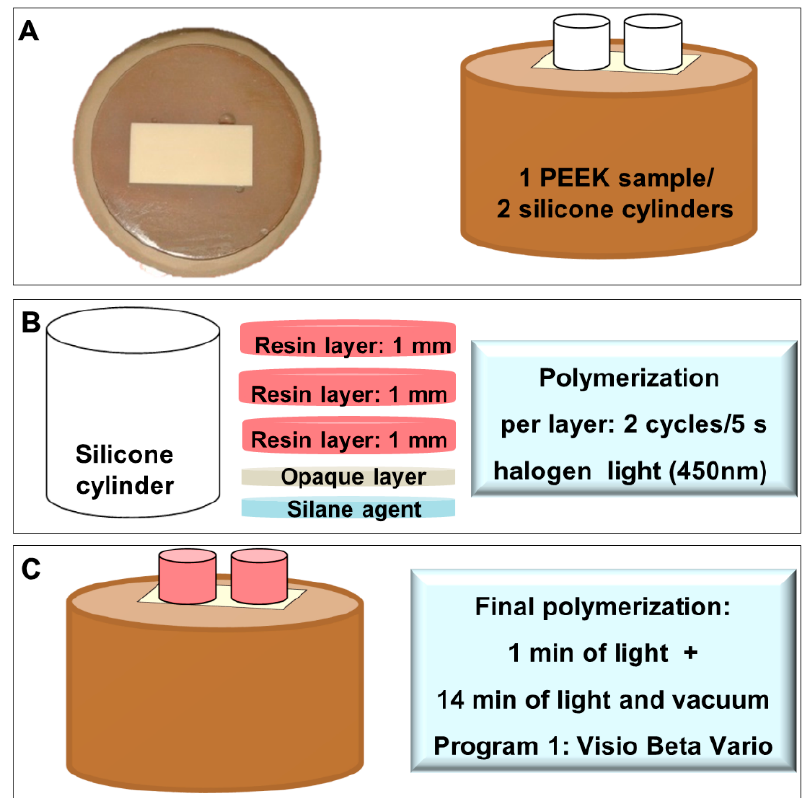
Figure 2. Sample preparation for shear bond testing. ( A ) Left: one PEEK sample embedded in epoxy resin. Right: two silicone cylinders perpendicularly positioned over pretreated PEEK delimiting the bonding area. ( B ) Successive layers of veneering system applied during the bonding procedure. ( C ) Set prepared for the final photopolymerization.